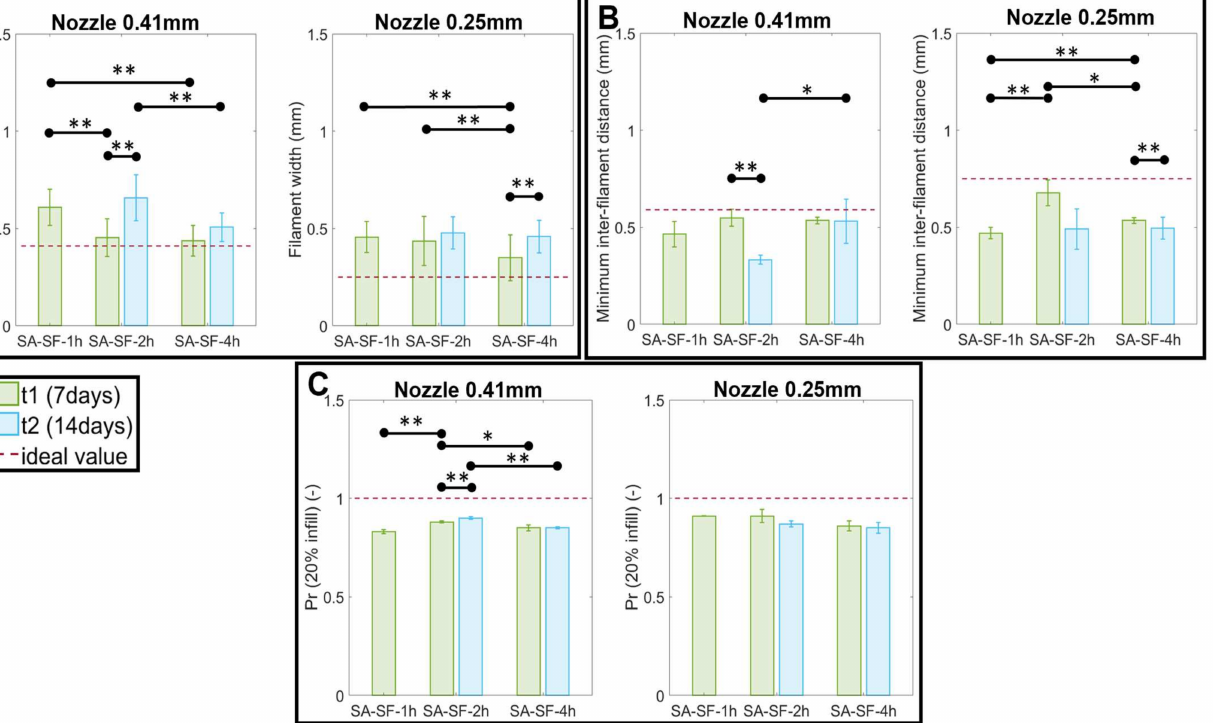
Figure 4. Results of shape fidelity assessment: ( A ) filament width; ( B ) minimum inter-filament distance (1 mm–D nozzle ); ( C ) printability index. Data are reported as mean values ± SD. * p < 0.05, ** p <